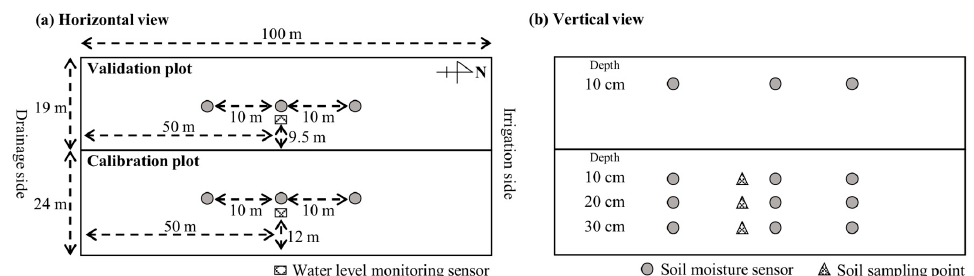
Figure 3. Schematic diagram of the experimental plot. ( a ) Horizontal view; ( b ) vertical view.